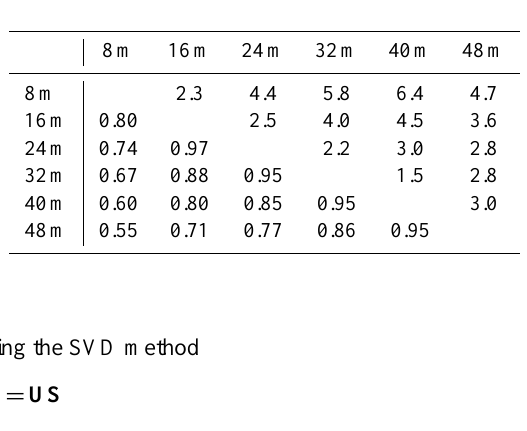
Table 3. Complex correlation coefficient matrix of horizontal cur- rents: absolute values are shown in the lower-left part whereas an- gles in degree are in the upper-right portion of the